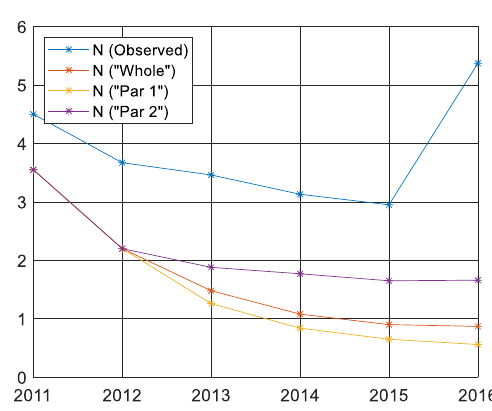
Fig. 3. Comparison between model results and observed concentrations, yearly averaged values (total nitrogen).